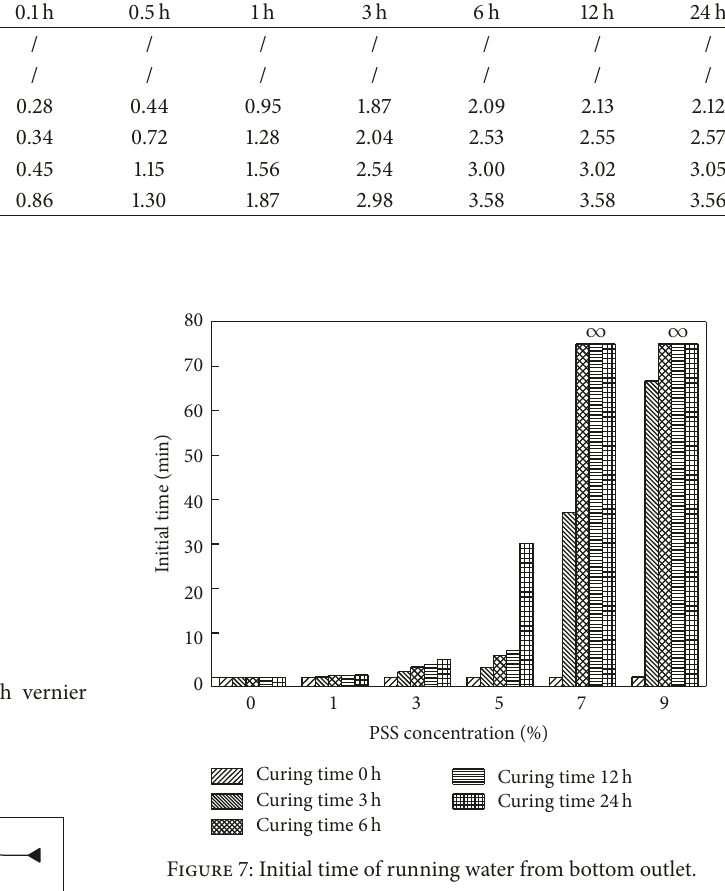
9% with curing time of 24 h were approximately 2.12, 2.57, 3.05, and 3.56 cm,